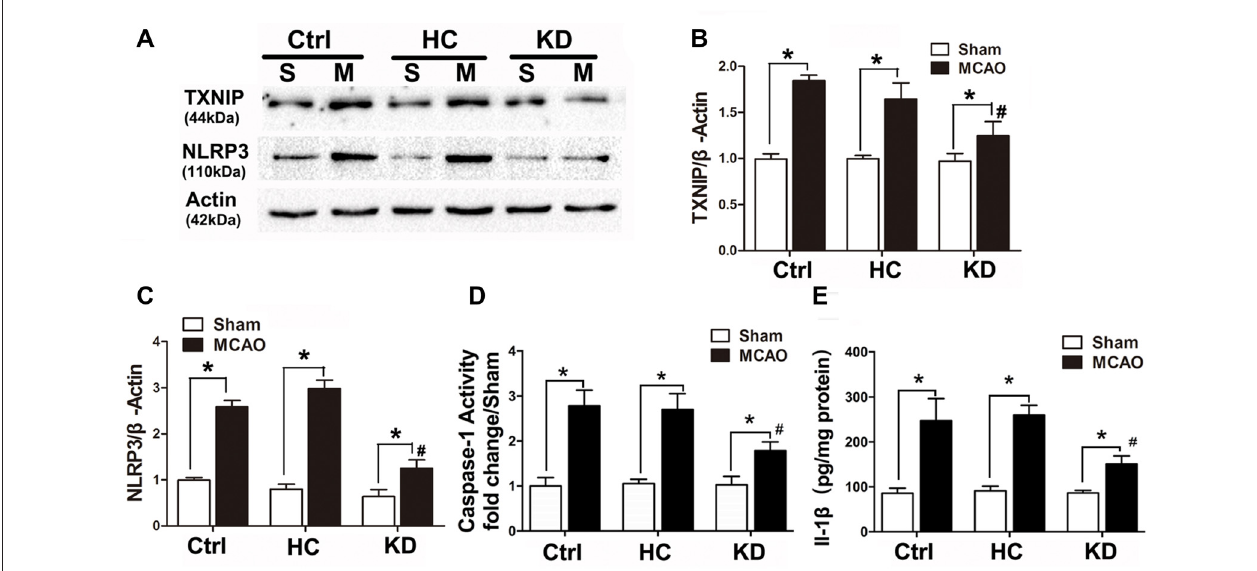
FIGURE 2 | KD suppressed thioredoxin-interacting protein (TXNIP)-nucleotide-binding domain (NOD)-like receptor protein 3 (NLRP3) inflammasome pathway in MCAO mice. Sham-operated and MCAO mice ( n = 6 per group) were fed with different diet protocols and protein expression was detected by Western blotting. (A) Representative blots from six independent experiments with similar results are shown. TXNIP (B) and NLRP3 (C) protein expression were determined. (D) Caspase-1 activity and IL-1 β concentration (E) were determined by enzyme-linked immunosorbent assay (ELISA). Caspase-1 activity was detected on brain lysates and compared to that in sham-operated mice. IL-1 β concentration is expressed per mg of total protein in brain tissue lysates. Data are shown as mean ± SEM; ∗ P < 0.01 vs. sham-operated mice, # P < 0.05 vs. MCAO group.